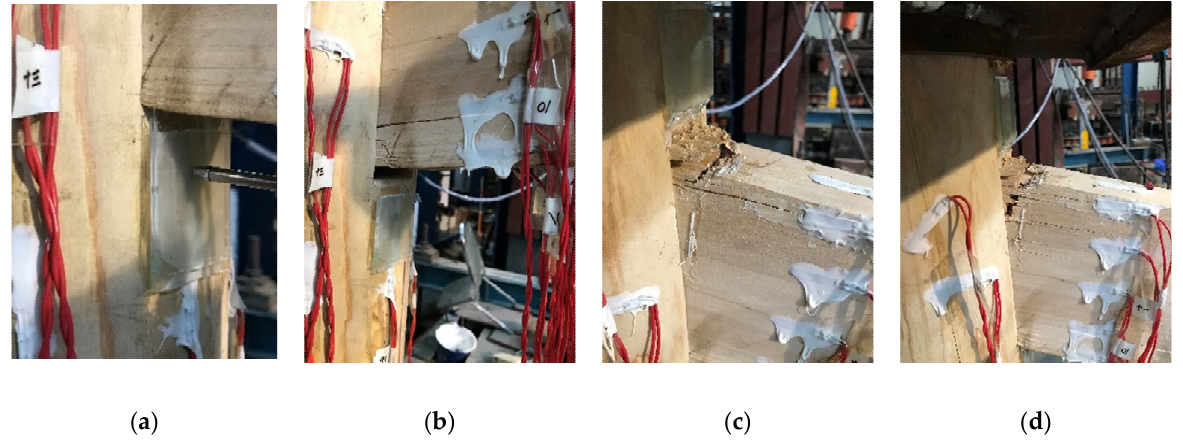
Figure 14. Experimental phenomena and failure modes of specimen BS1: ( a ) slight extrusion deformation; ( b ) cracking at the bottom of the tenon neck; ( c ) cracking at the top of the tenon neck; ( d ) tensile damage.